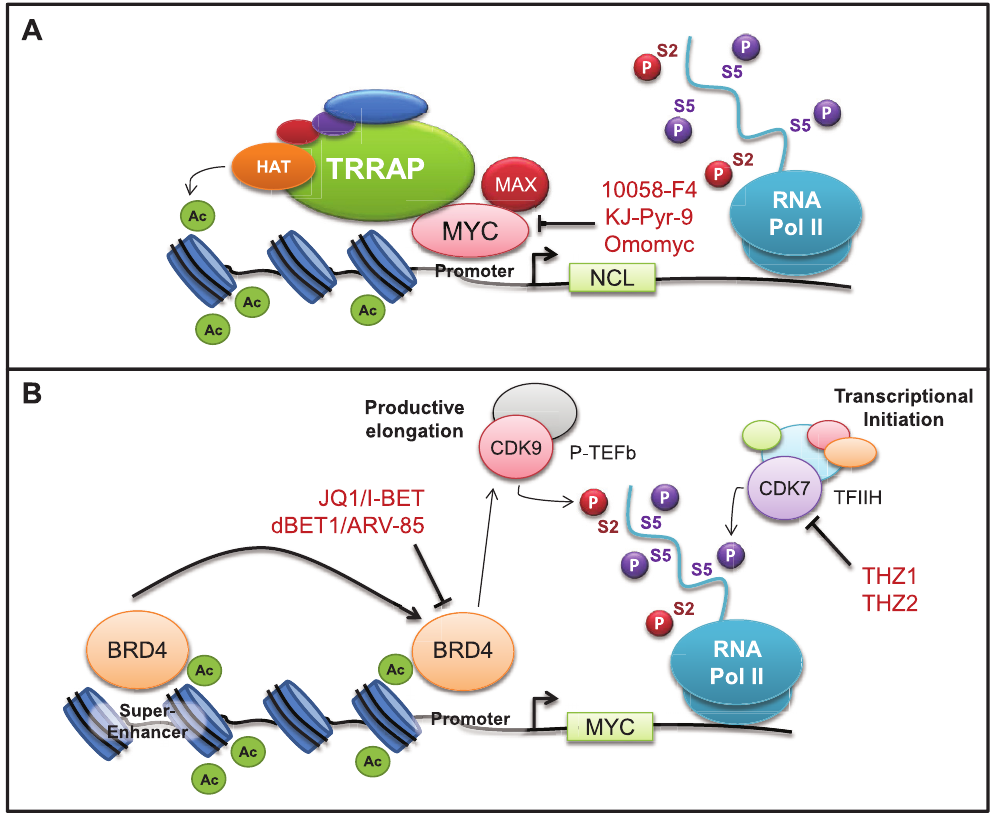
Figure 1. Direct and indirect inhibition of MYC. ( A ) Targeting the MYC/MAX interface by using 10058-F4, KJ-Pyr-9, or Omomyc inhibits binding to DNA and the MYC transcriptional pathway. ( B ) Indirect targeting of MYC expression through inhibition of CDK7 or BRD4, key factors involved in transcriptional initiation and elongation, using JQ1/dBET1 or THZ1/THZ2, respectively. Targeting CDK7 or BRD4 results in specific downregulation of MYC protein